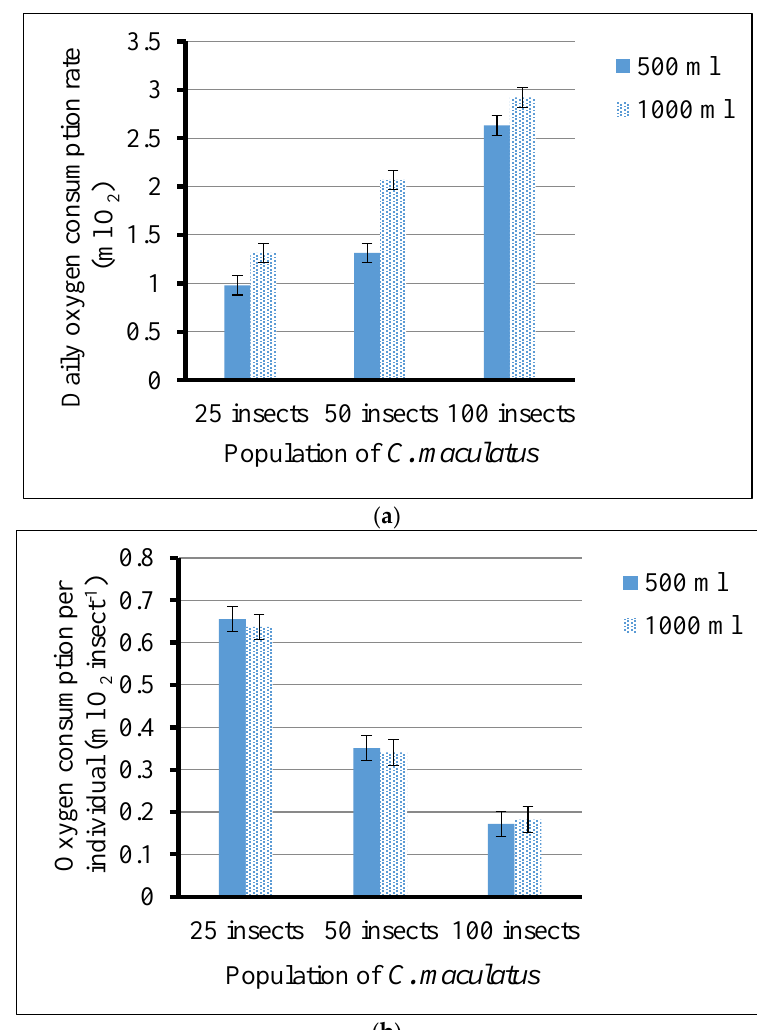
Figure 2. Measures of oxygen consumption during the time for the residual oxygen to deplete to 4%, t 4% , after initiation of treatments: ( a ) Estimated daily O 2 consumption for different treatments (Total mL O 2 consumed/ t 4% ); ( b ) Estimated individual O 2 consumption (Total mL O 2 consumed per insect) .